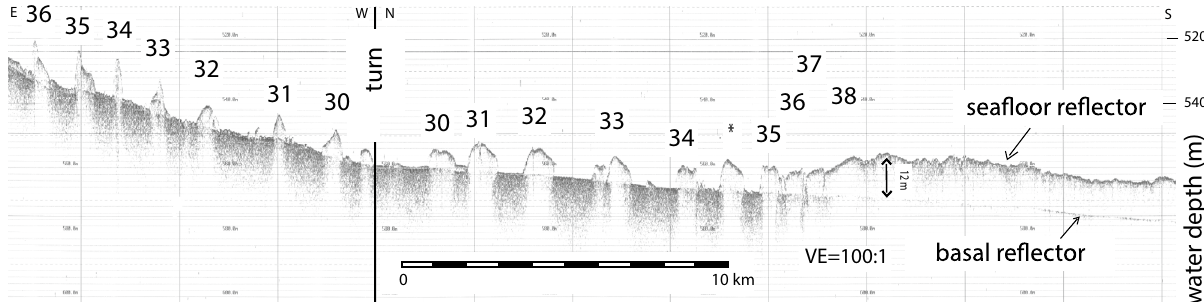
Figure 3. Sonar transects showing steep-flank ridges and basal reflector underlying ridges 29–50. The transect location is shown on Fig.